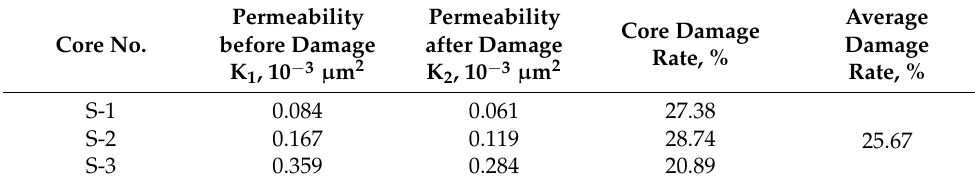
Table 9. Results of the core damage tests.